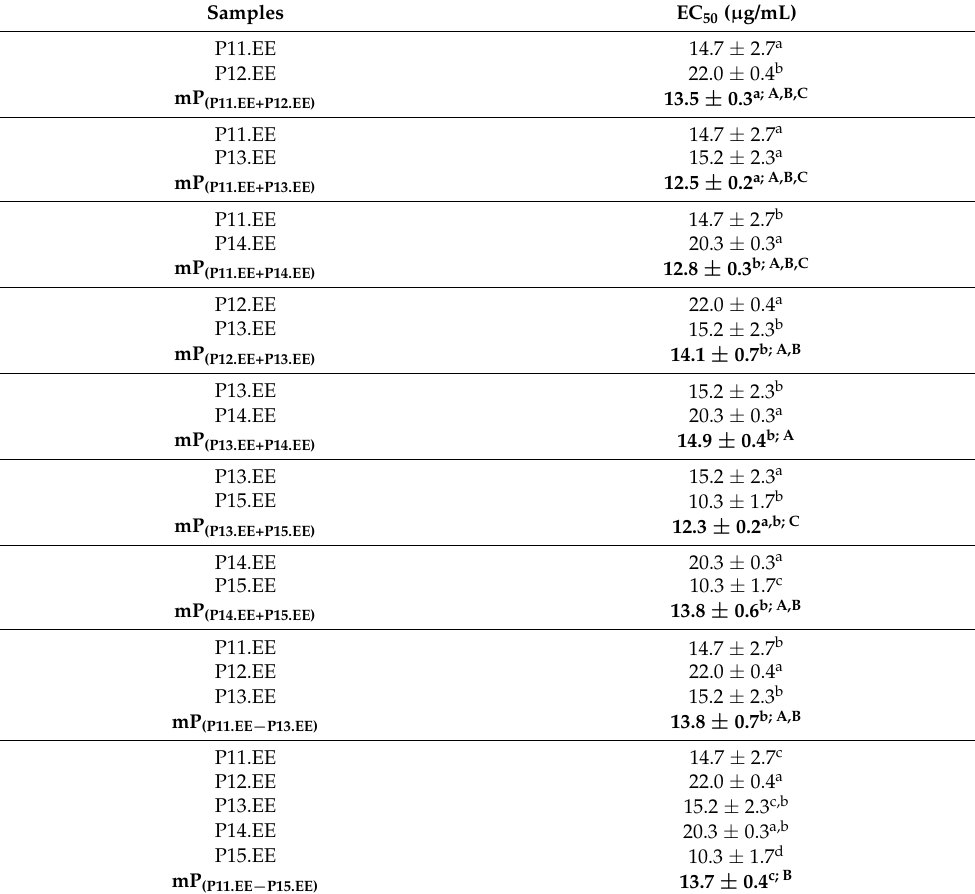
Table 2. P.EEs’ and mP.EEs’ ability to capture DPPH • free radicals. Antioxidant potential is expressed as a mean ± standard deviation of EC 50 values ( µ g/mL). Significant differences between single P.EEs and mP.EEs ( p < 0.05) are noted with different lowercase letters. Significant differences between mP.EEs ( p < 0.05) are represented with different uppercase